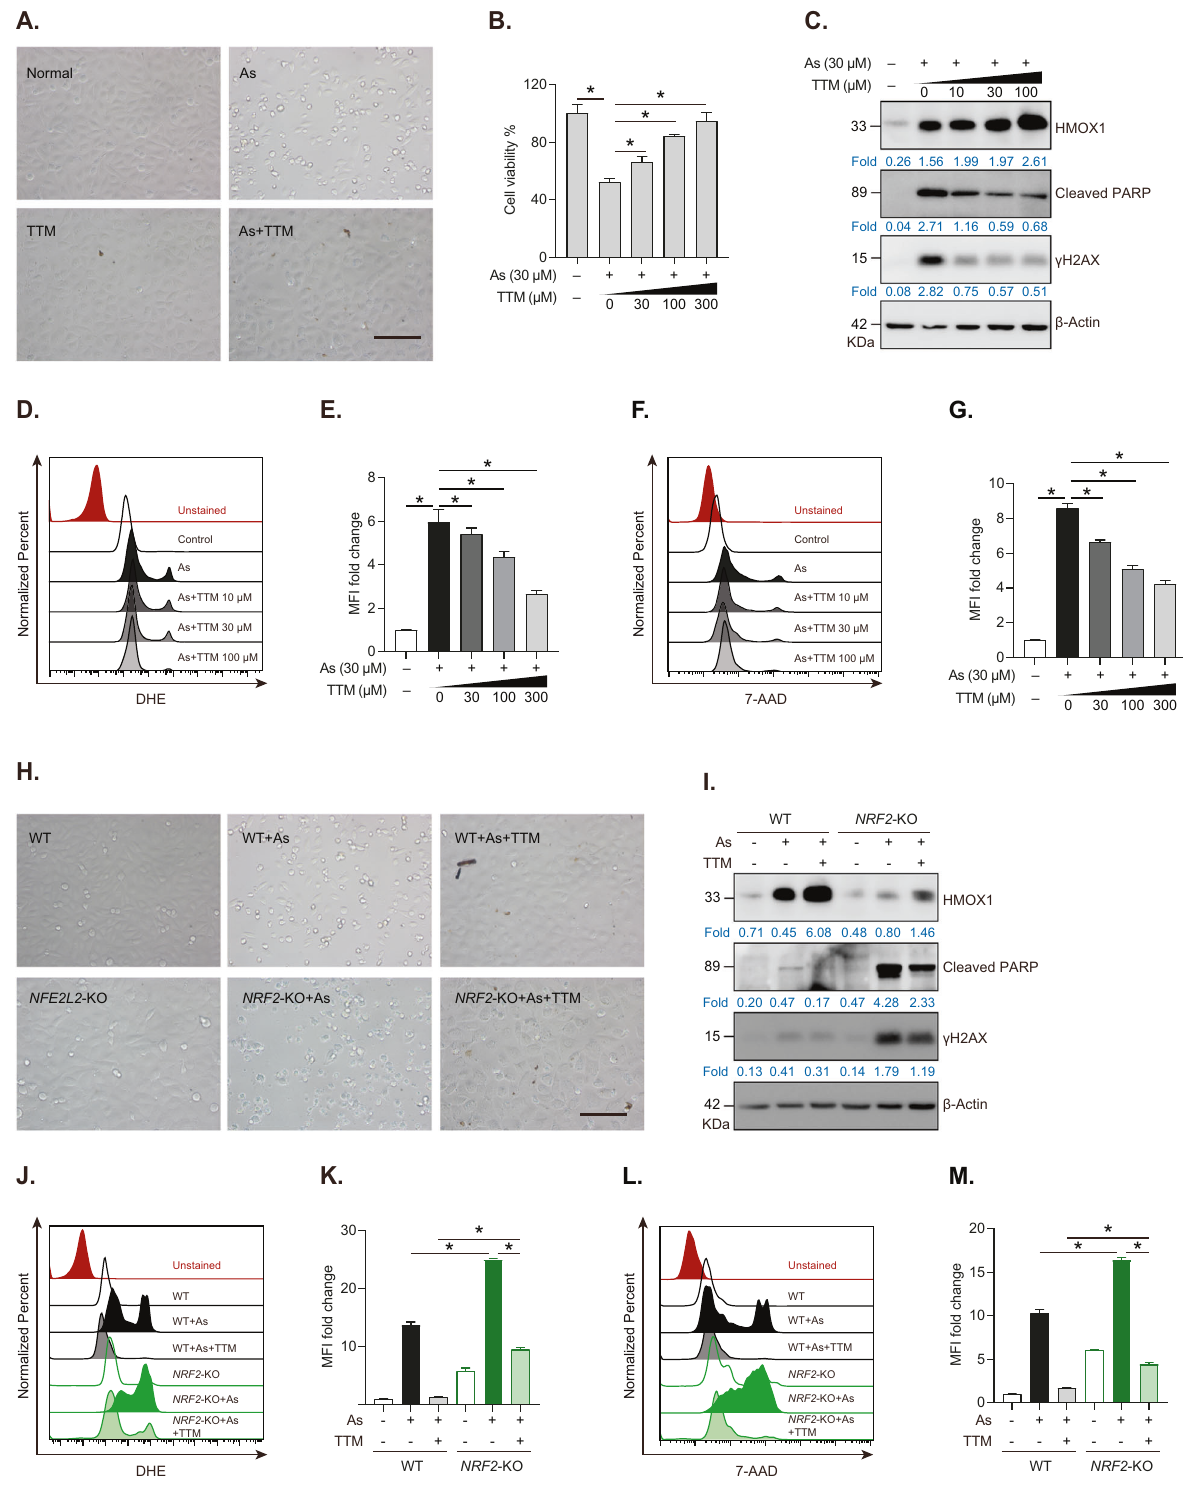
knockout undermined protective effects of TTM against treatment decreased protein levels of cleaved PARP (an NaAsO 2 -induced cell death (Figs. 5H and S1F). Immunoblotting apoptotic marker) and γ H2AX (a sensor of DNA damage) induced by NaAsO 2 exposure (Fig. 5C). FACS data showed that results revealed that NRF2 knockout signi fi cantly elevated TTM decreased ROS levels and signi fi cantly repressed 7-AAD protein levels of cleaved PARP and γ H2AX in cells co-treated fl uorescence (an apoptotic probe) in NaAsO with NaAsO 2 and TTM (Fig. 5I). Consistently, FACS data 2 -treated HUVECs (Fig. 5D – G). More importantly, we demonstrated that NRF2 demonstrated that NRF2 knockout enhanced cellular